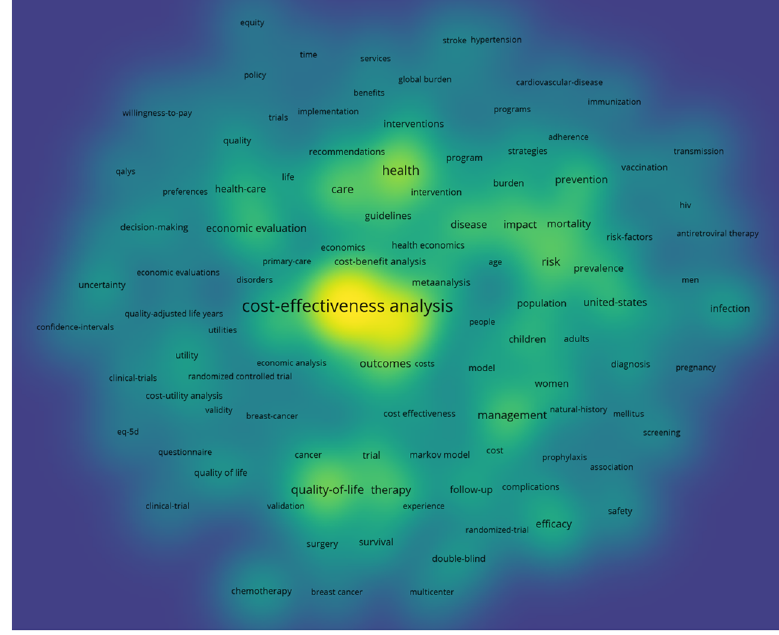
Fig. 10 Keyword density. Source: Authors.